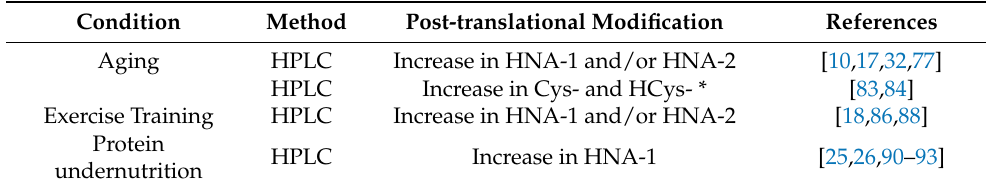
Table 3. Serum albumin (ALB) redox state in physiological conditions. Condition